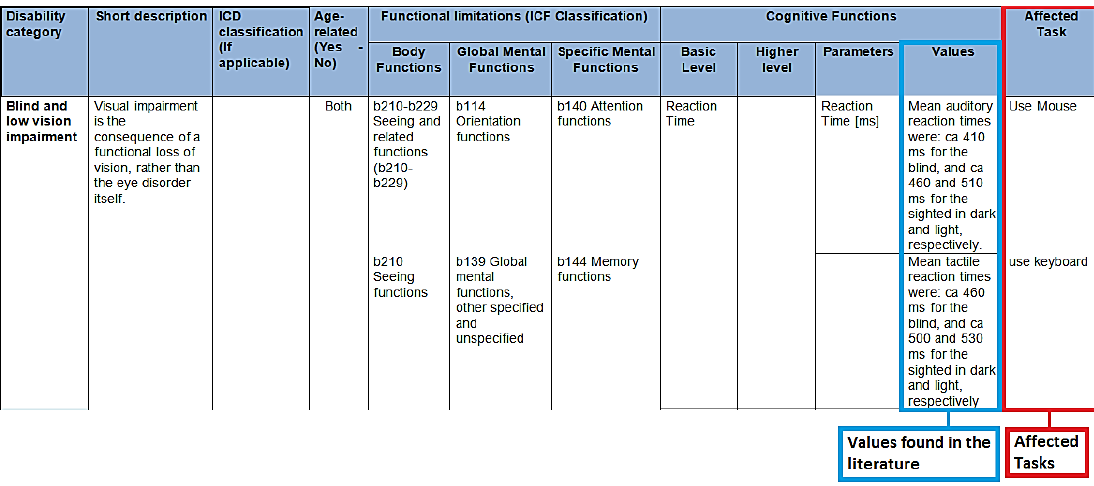
Figure 7. GCVUM with the ACT-R parameters. Notes: Alcantud et al. [47], Serna et al. [48]. 3.5. Representation of the GCVUM through Ontology Ontologies were used to provide complete specification and representation of the final Cognitive Virtual User Model. The user models stored in the ontology includes: (1) the type of disability; (2) user capabilities; (3) user needs; (4) characteristics from cognitive user models; and (5) guidelines and standards.